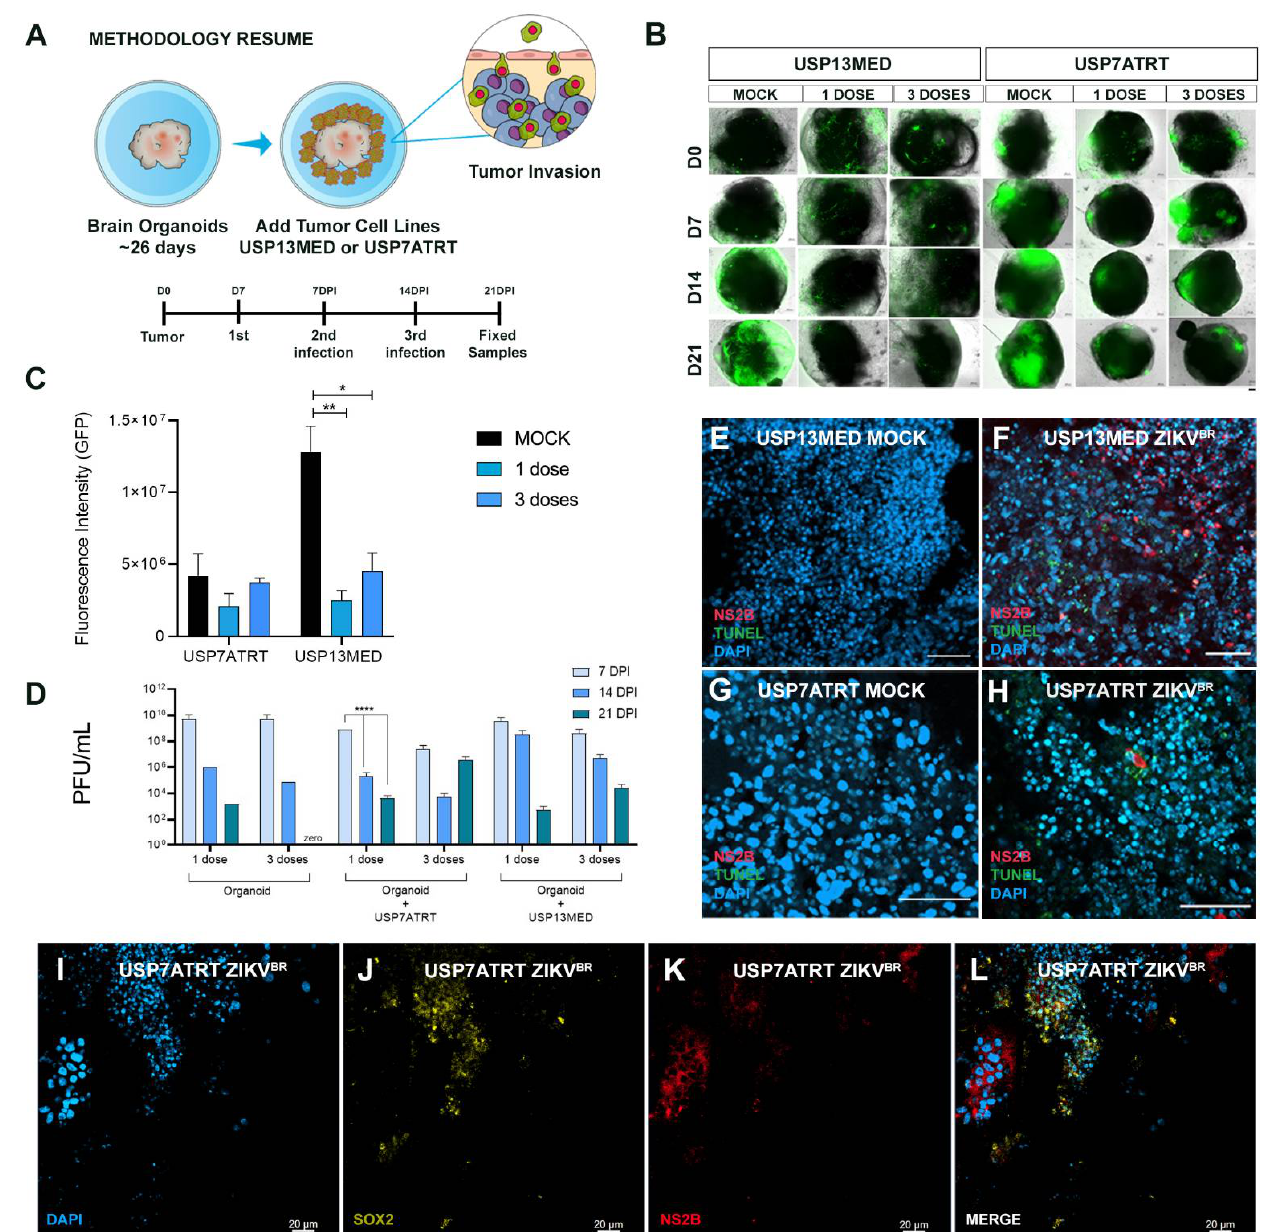
Figure 4. ZIKV BR infection of CNS tumor cells co-cultured with brain organoids. ( A ) Schematic representation of brain organoids-CNS tumor cells co-culture assay (DPI: days post-infection). ( B , C ) fluorescence microscopy analysis of 26-day-old brain organoids co-cultured with 10 3 GFP + USP13MED and USP7ATRT cells and treated with none, one or three ZIKV BR doses ( B ) (scale bar 20 µ m). ( C ) Quantification of GFP fluorescence intensity on 21 DPI images of organoids co-cultured, n = 4. ( D ) Supernatant PFU assays from co-cultured treated with none, one or three ZIKV BR doses at 7, 14, and 21 DPI. Immunolabeling for non-structural ZIKV BR protein NS2B (red) and cell death (TUNEL, green), and SOX2 (yellow) on 21 DPI images of organoids co-cultured with USP13MED ( E , F ) and USP7ATRT ( G – L ), scale bar 50 µ m ( B , E – H ) and 20 µ m ( I – L ). ( n = 4 per group) * p ≤ 0.05. ** p ≤ 0.01. **** p ≤